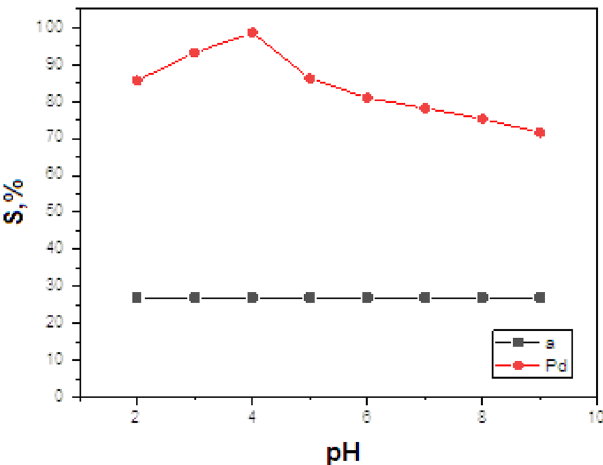
Figure 7. Effect of pH on sublation efficiency of Pd (II); ( a ) in the absence of A1; ( b ) in the presence of 2.0 × 10 −4 mol L −1 A1 by using 5 × 10 −4 mol L −1 TBAB; 2 × 10 −3 mol L −1 HOL; MIBK (5 ml) at room temperature.